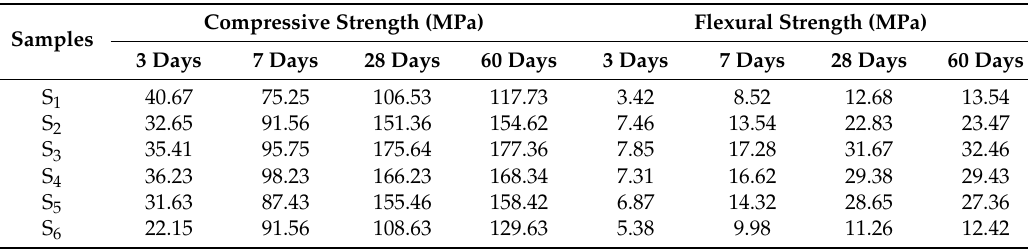
Table 5. The compressive and flexural strengths of GO/cement composites.